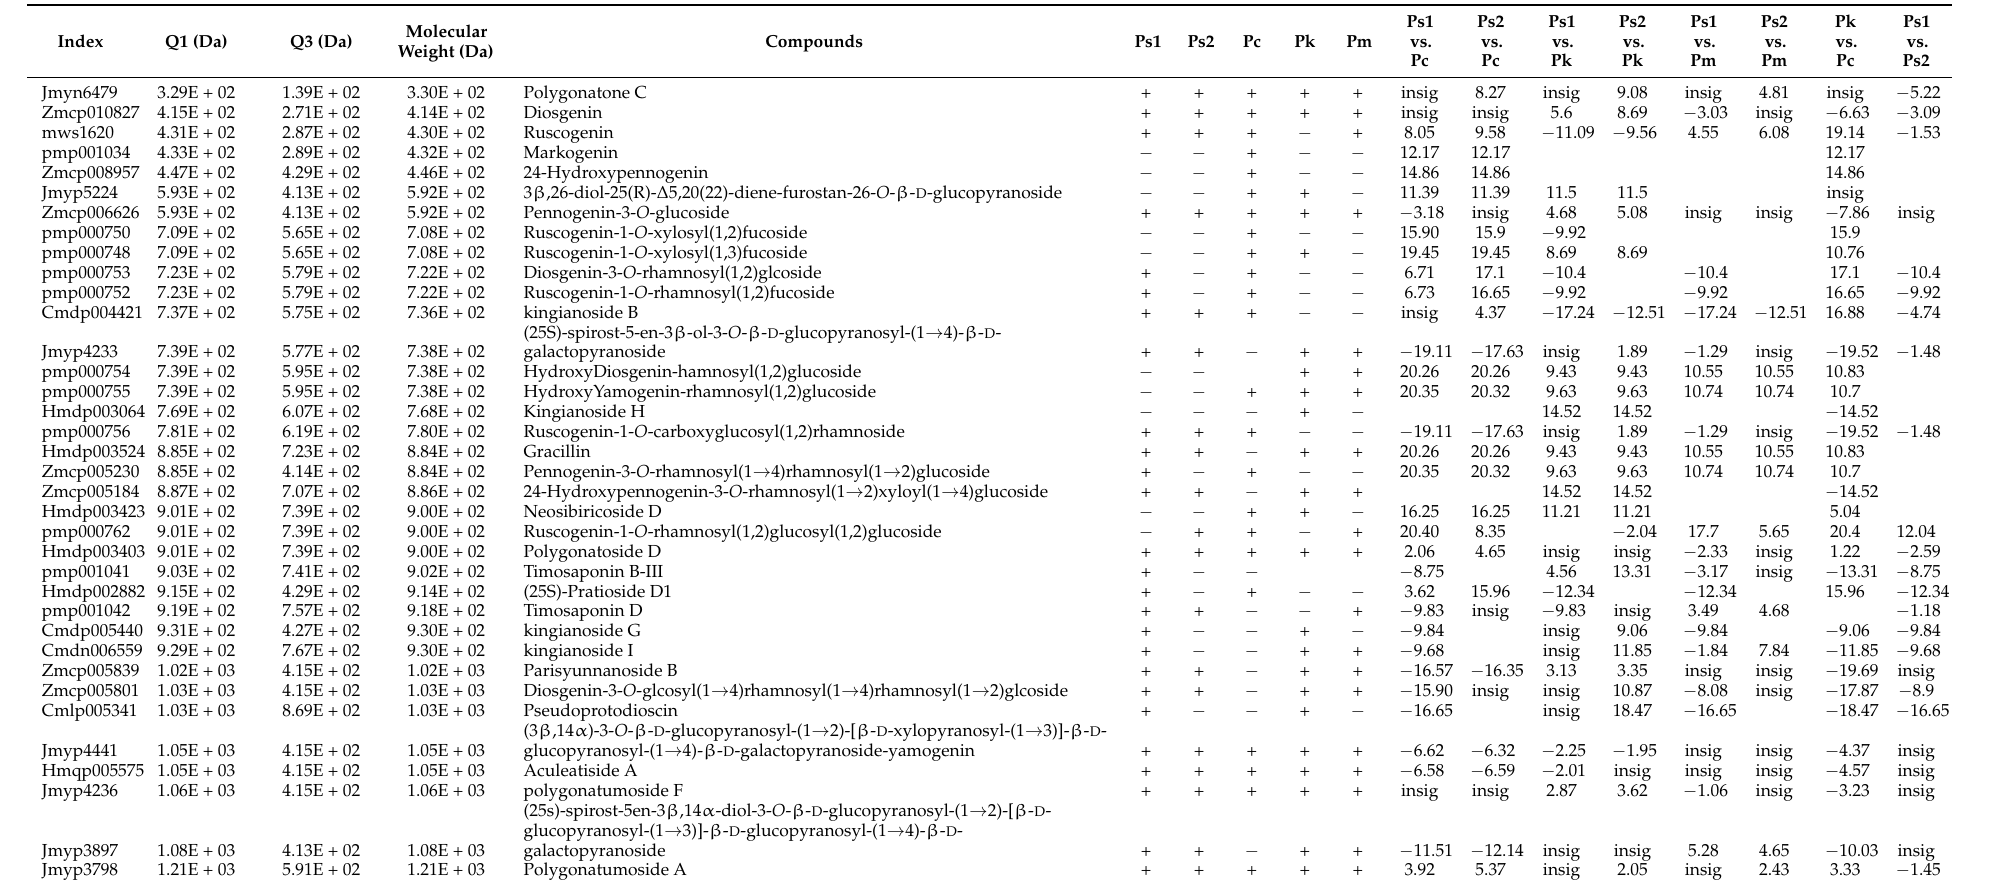
Table 2. Identification of steroidal saponins in the seeds of four Polygonatum species and pairwise comparisons of the